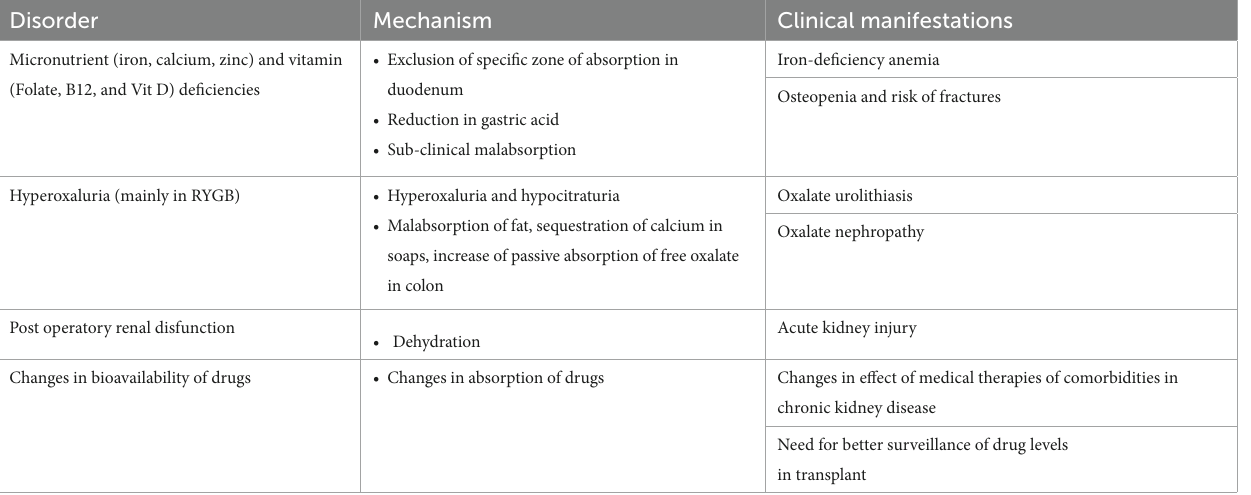
TABLE 3 Non-surgical adverse effects of bariatric